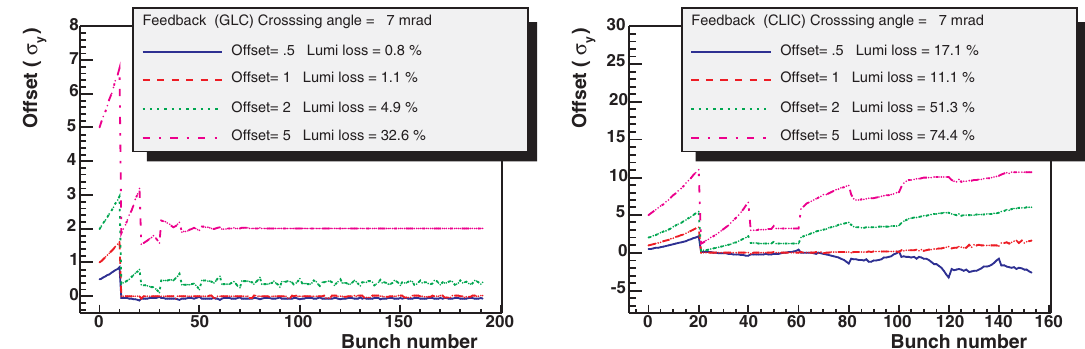
FIG. 12. (Color) Correction of the beam offset using the circuit shown on Fig. 11. The gain used for the simple feedback loop is 0.5 for the GLC and 0.7 for CLIC. The gains used in the other part of the circuit have been tuned so that the beam offset becomes null if the initial offset was